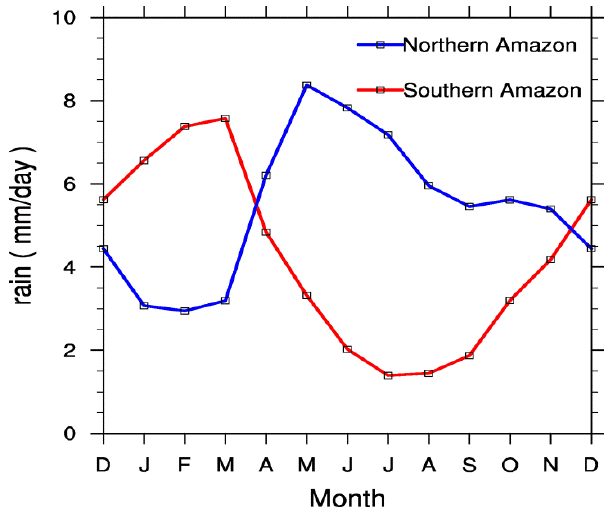
Figure 12. Averaged rain rate in northern and southern Amazon (divided by the equator) from the Global Precipitation Climatology Project (GPCP) dataset